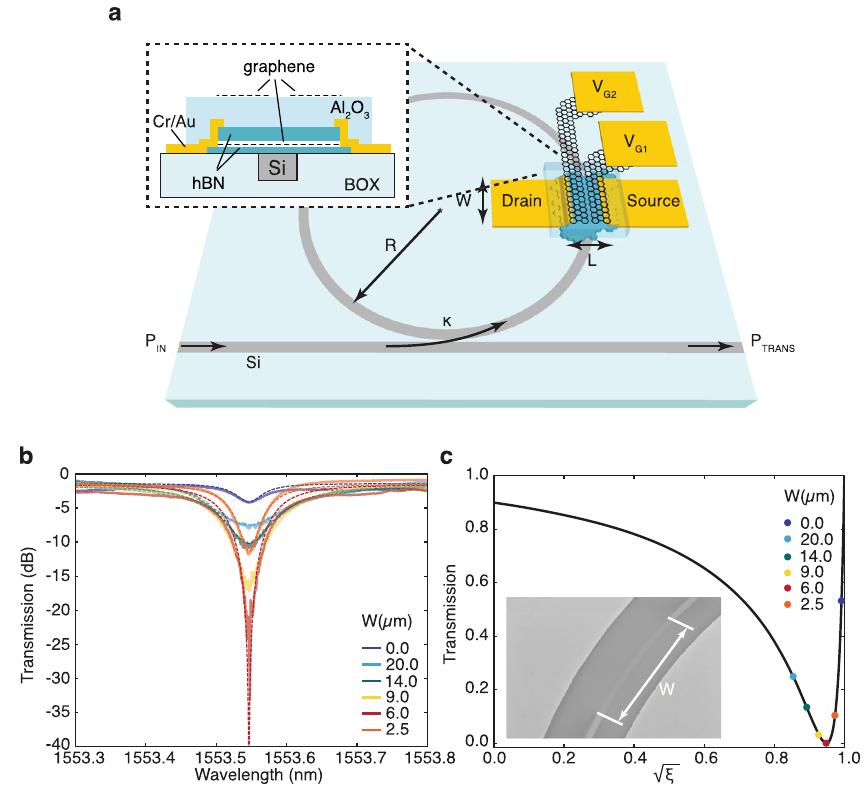
Fig. 1 Si ring resonator integrated GPD. a Sketch of device. b Transmission spectra of a ring cavity with SLG on top, indicating the effects of varying W on ER and Q. For clarity, the spectra are aligned at the resonance wavelength closest to 1553.55 nm. c Corresponding transmission at resonance. The black line is the calculated transmission for κ = 10%. The coloured dots mark the transmission for various loss coef fi